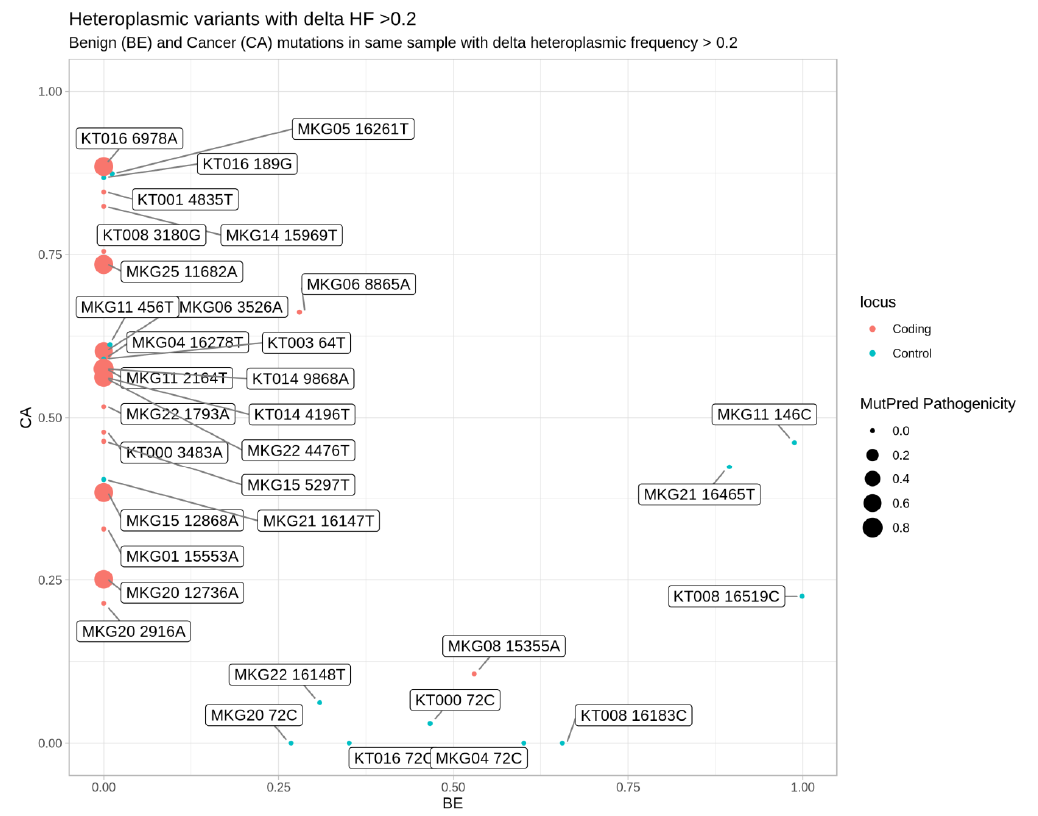
Figure 4. Mitochondrial variations with delta heteroplasmic frequency between benign and cancer tissue of at least 20%. In the graph are displayed: on the axes, the variant frequency in the cancer tissue (y-axis) and the variant frequency in the benign tissue (x-axis), in rectangle labels the genome positions and sample ID, with the MutPred Pathogenicity Score represented by the point size and colored according to the presence in either coding region including rRNA and tRNA variants or control region (D-Loop 1 and D-Loop 2).